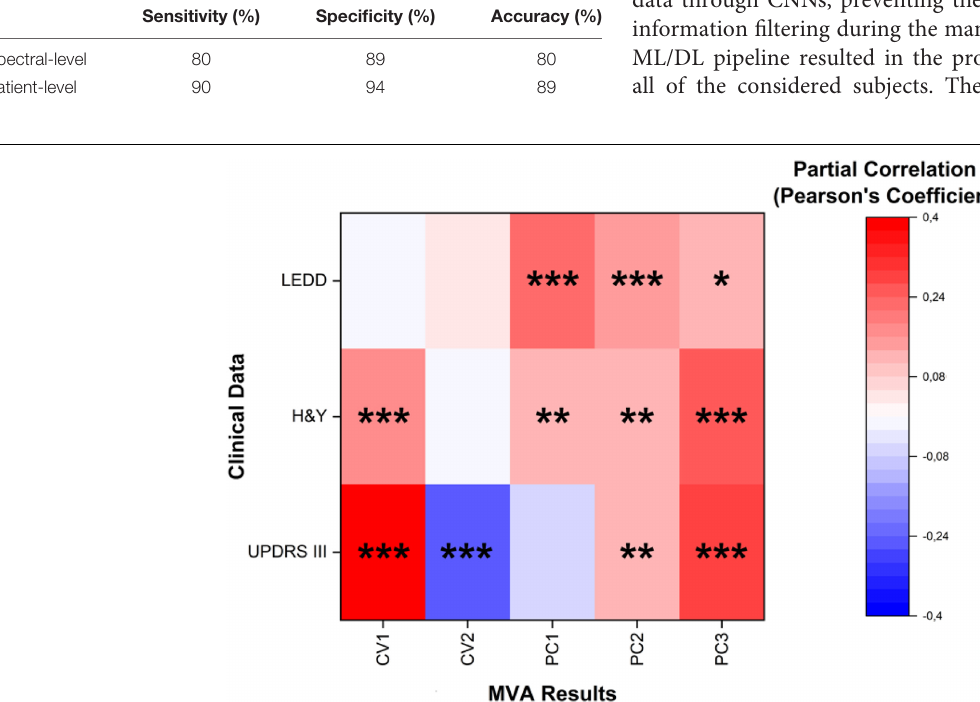
TABLE 4 | Accuracy, sensitivity, and specificity in patient- and spectra-level obtained by the proposed CNN in leave-one-patient-out cross-validation using a 10 × data augmentation.